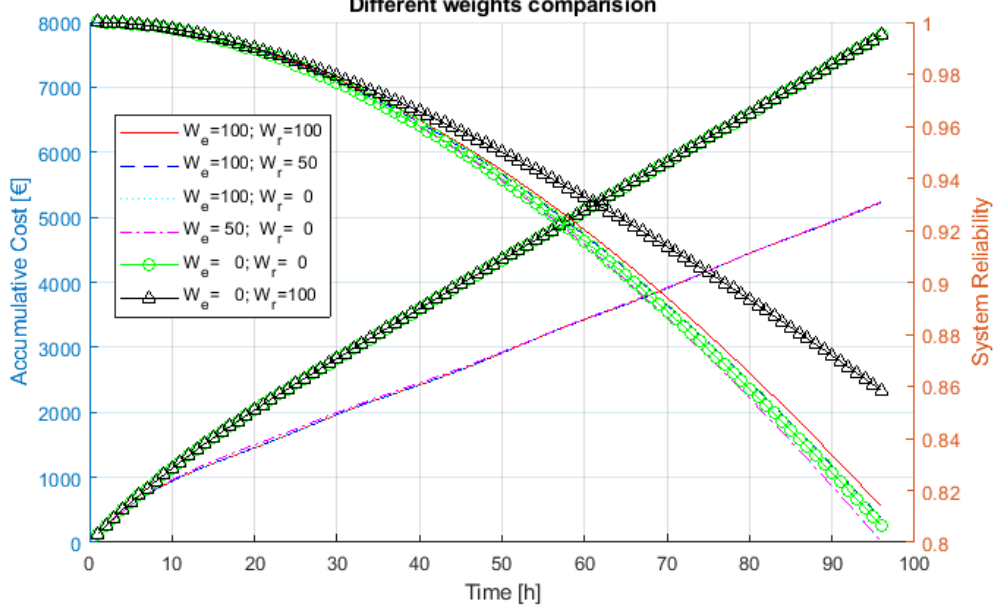
Figure 7. System reliability and accumulative cost for different weights